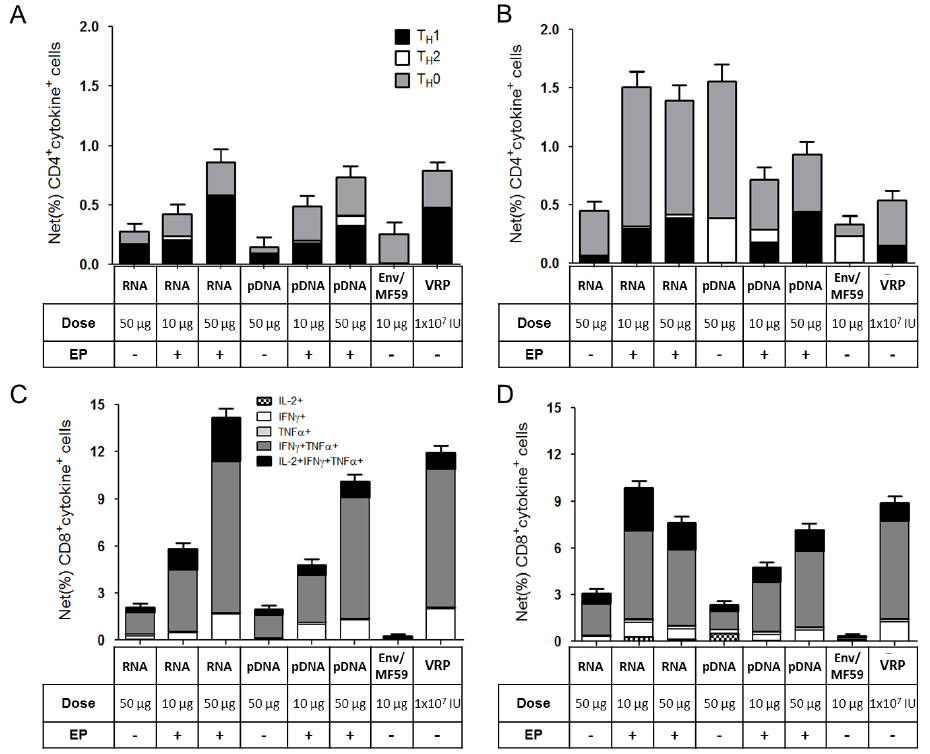
Figure 5. T-cell responses for groups treated with self-amplifying mRNA (RNA, 10 and 50 µg), pDNA (pDNA, 10 and 50 µg), MF59-adjuvanted Env (Env/MF59, 10 µg) or viral replicon particles (VRP, 1 × 10 7 IU) at weeks 5 ( A , C ) and 10 ( B , D ). Pooled splenocytes (6 spleens/pool) were stimulated with HIV Env-derived antigenic peptides, stained for intra-cellular cytokines, and subjected to flow cytometry (methods). Graphs show the Env-specific (%) frequencies of CD4 + ( A , B ) and CD8 + ( C , D ) T-cells with error bars denoting 95% confidence